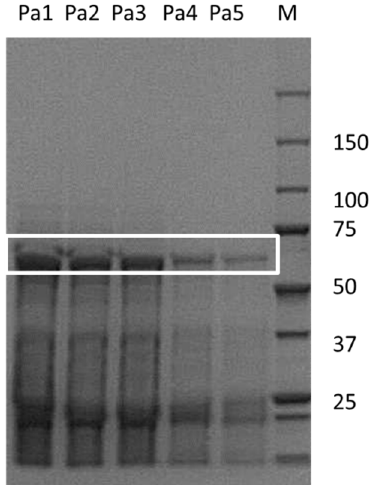
Figure 1. The purity determination was performed with Genetool software according to manufactures instruction of Pa HNL on a sodium dodecyl sulfate–polyacrylamide gel electrophoresis (SDS ‐ PAGE) gel. The white box indicates the enzyme. Sample M is the marker, Pa1 to Pa5 are different concentrations of commercial samples of Pa HNL utilized in this study.